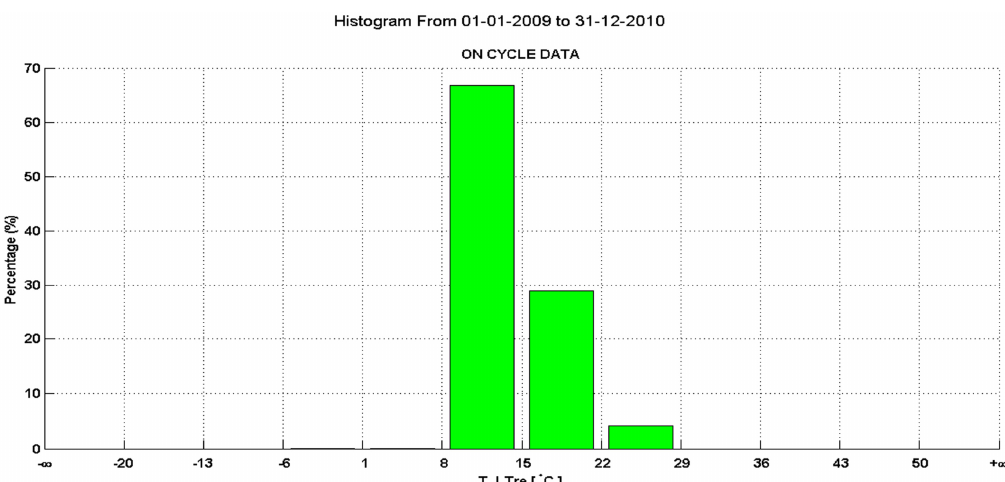
Figure 10. Histogram of the supply temperature in the high temperature cycle showing only the temperatures while the system is on. The data contains outliers.